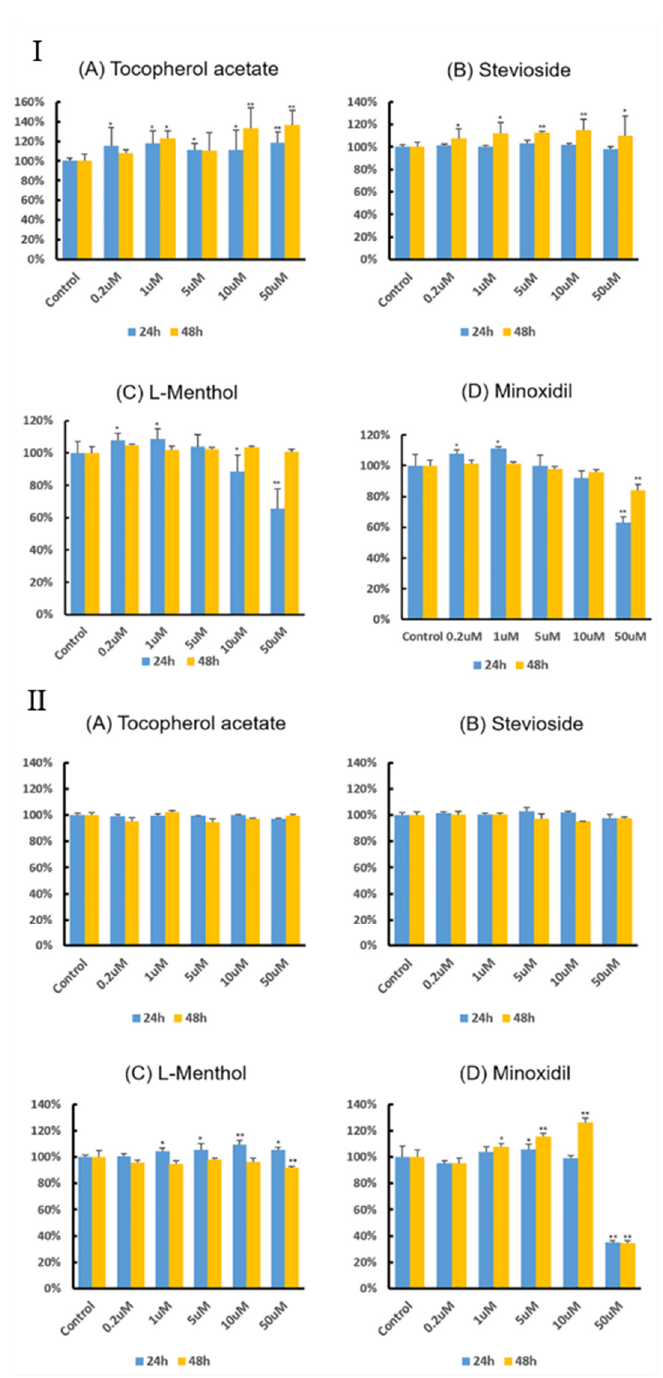
Figure 1. Ⅰ Effects of ( A ) tocopherol acetate, ( B ) stevioside, ( C ) L-menthol, and ( D ) minoxidil on keratinocyte proliferation. Cells were treated with each compound at indicated concentrations for 24 and 48 h. Results are presented as average and standard deviation. Statistical analyses were performed in comparison with the vehicle-treated control group (* p < 0.05; ** p < 0.01; n = 6). Ⅱ Effects of ( A ) tocopherol acetate, ( B ) stevioside, ( C ) L-menthol, and ( D ) minoxidil on human hair follicle dermal papilla (HDP) cell proliferation. Cells were treated with each compound at indicated concentrations for 24 and 48 h. Results are presented as average and standard deviation. Statistical analyses were performed in comparison with the vehicle-treated control group (* p < 0.05; ** p < 0.01; n = 3).